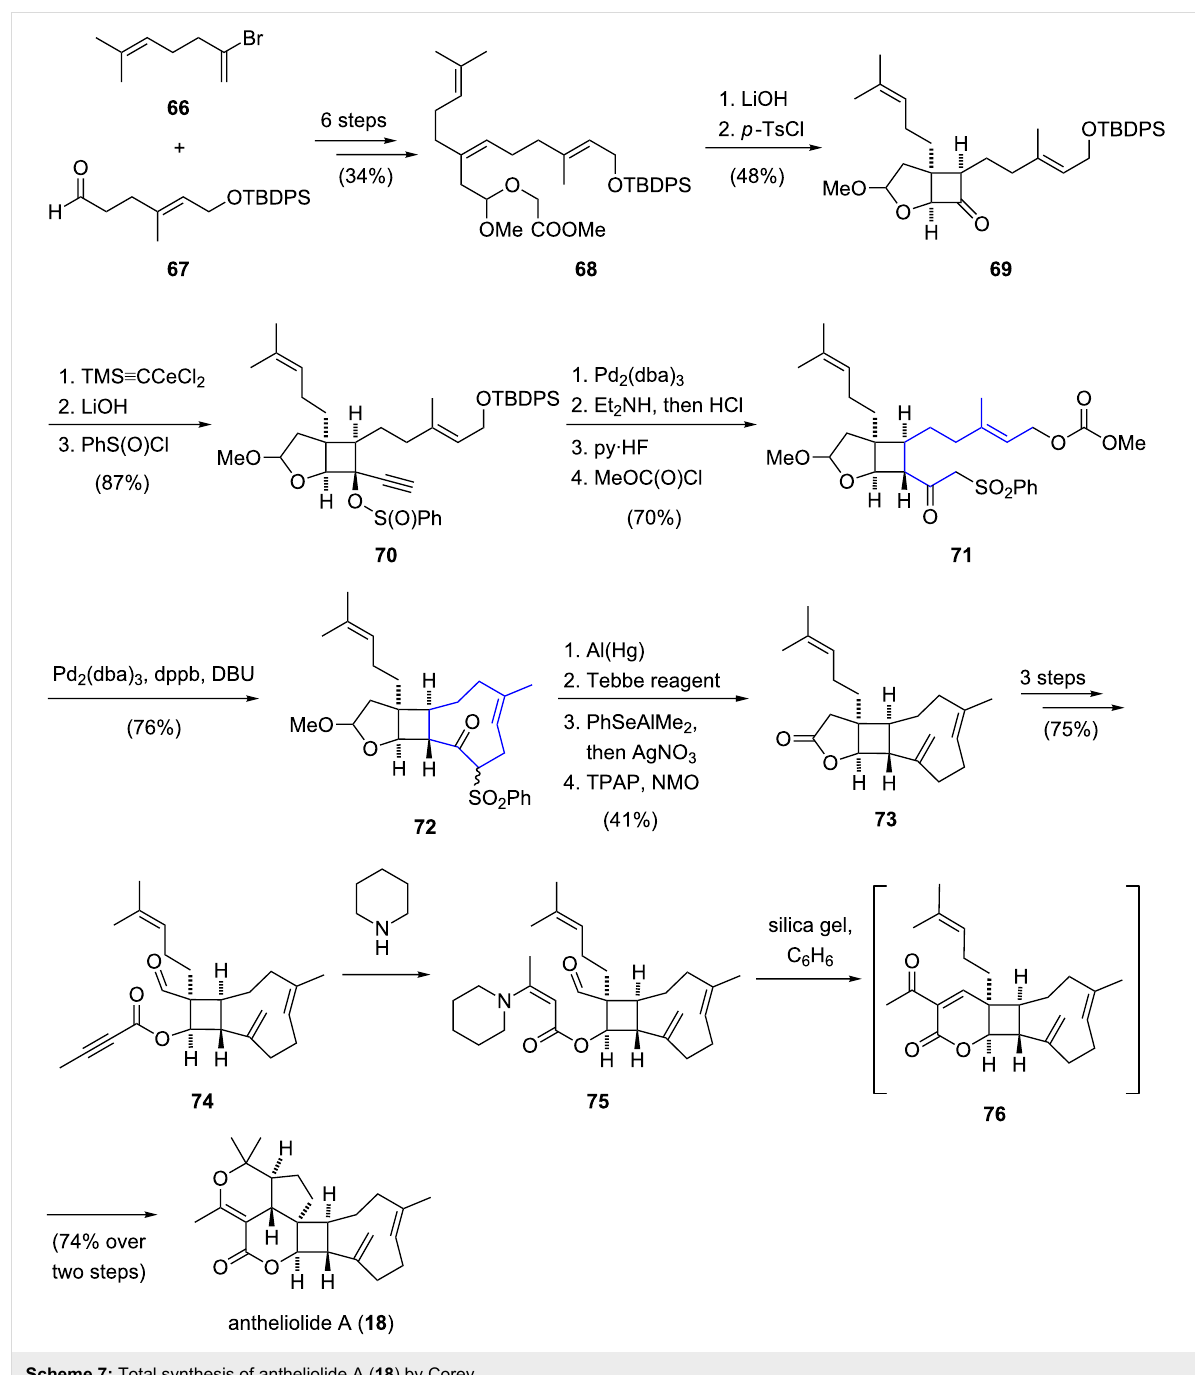
Scheme 7: Total synthesis of antheliolide A ( 18 ) by